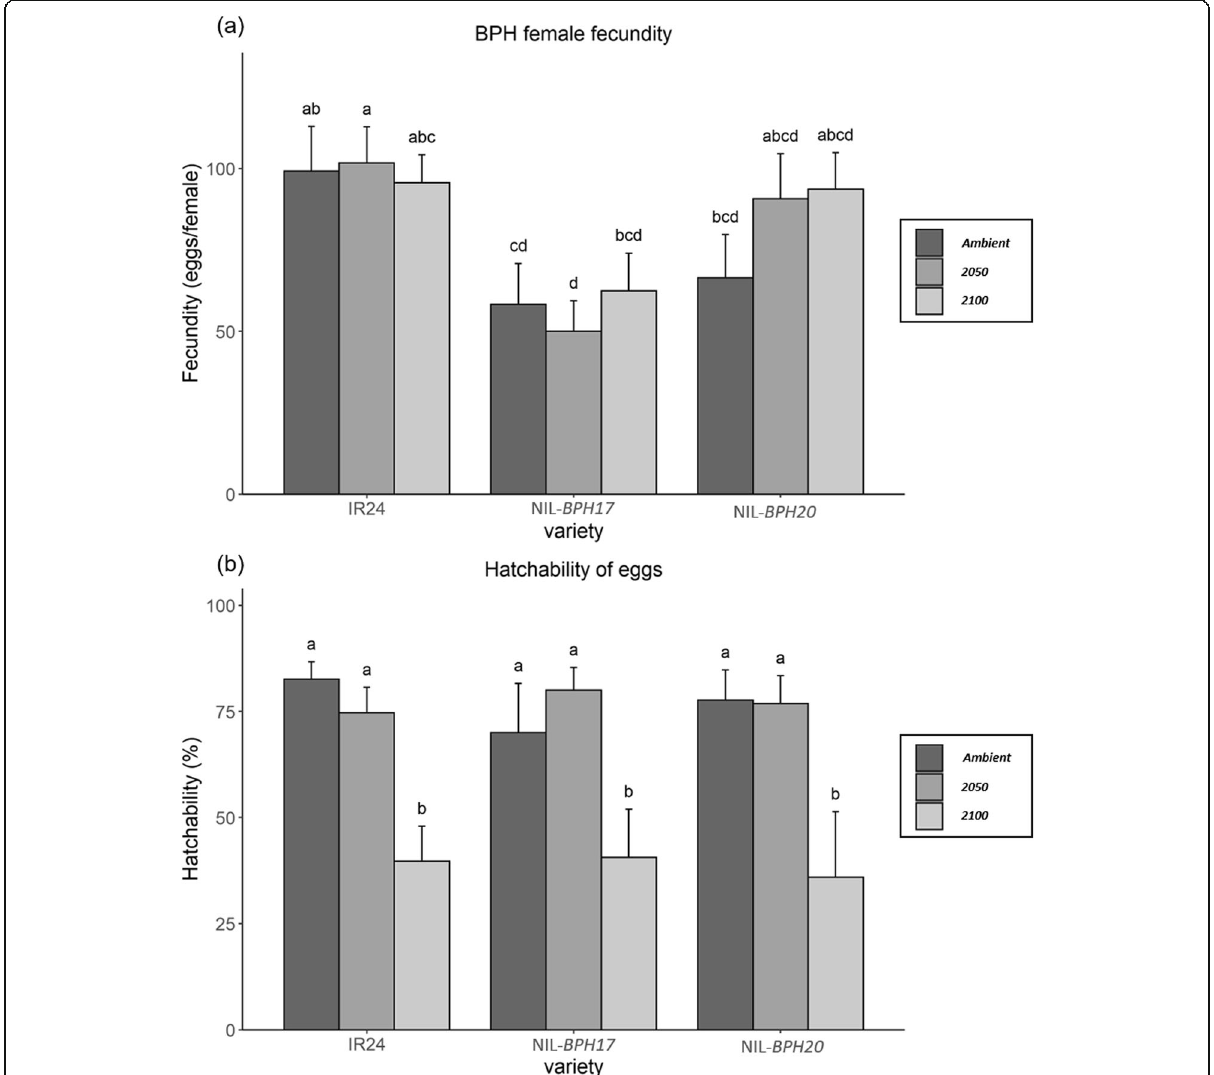
Fig. 6 The N. lugens female fecundity and hatchability of IR24 and NILs under different environments. a Fecundity. b Hatchability. Means in each column followed by a different letter differ significantly ( P <